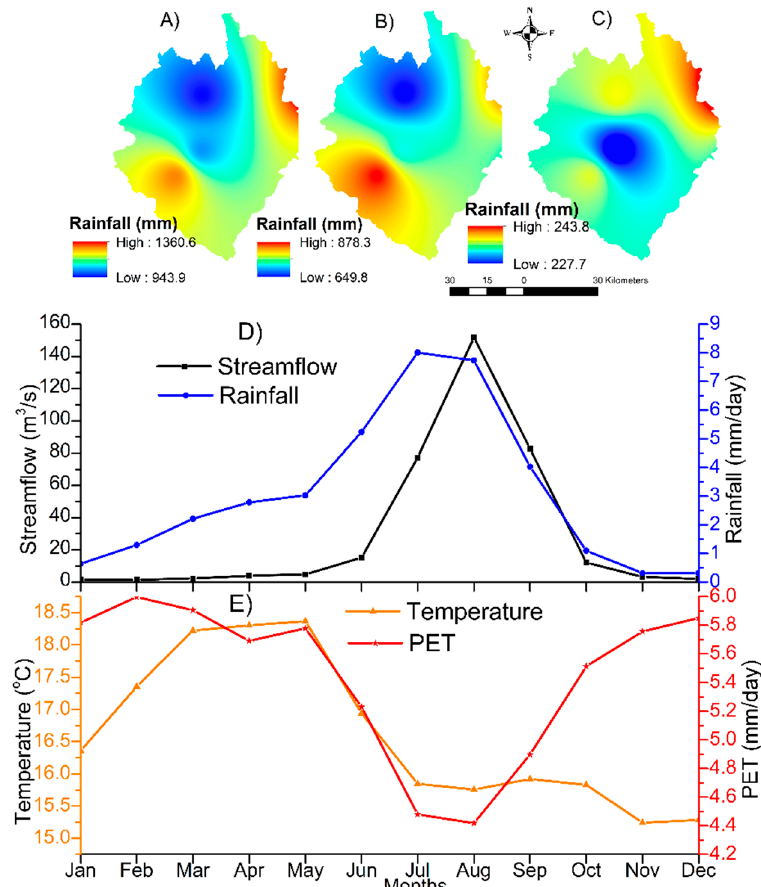
Figure 3. Observed rainfall, temperature, and streamflow and calculated potential evapotranspiration (PET) of Melka Kuntrie subbasin from 1990–2008: ( A ) annual rainfall; ( B ) major rain season rainfall; ( C ) minor rainy season rainfall; ( D ) average monthly streamflow and average areal rainfall; ( E ) average monthly temperature and average areal potential evapotranspiration (PET).